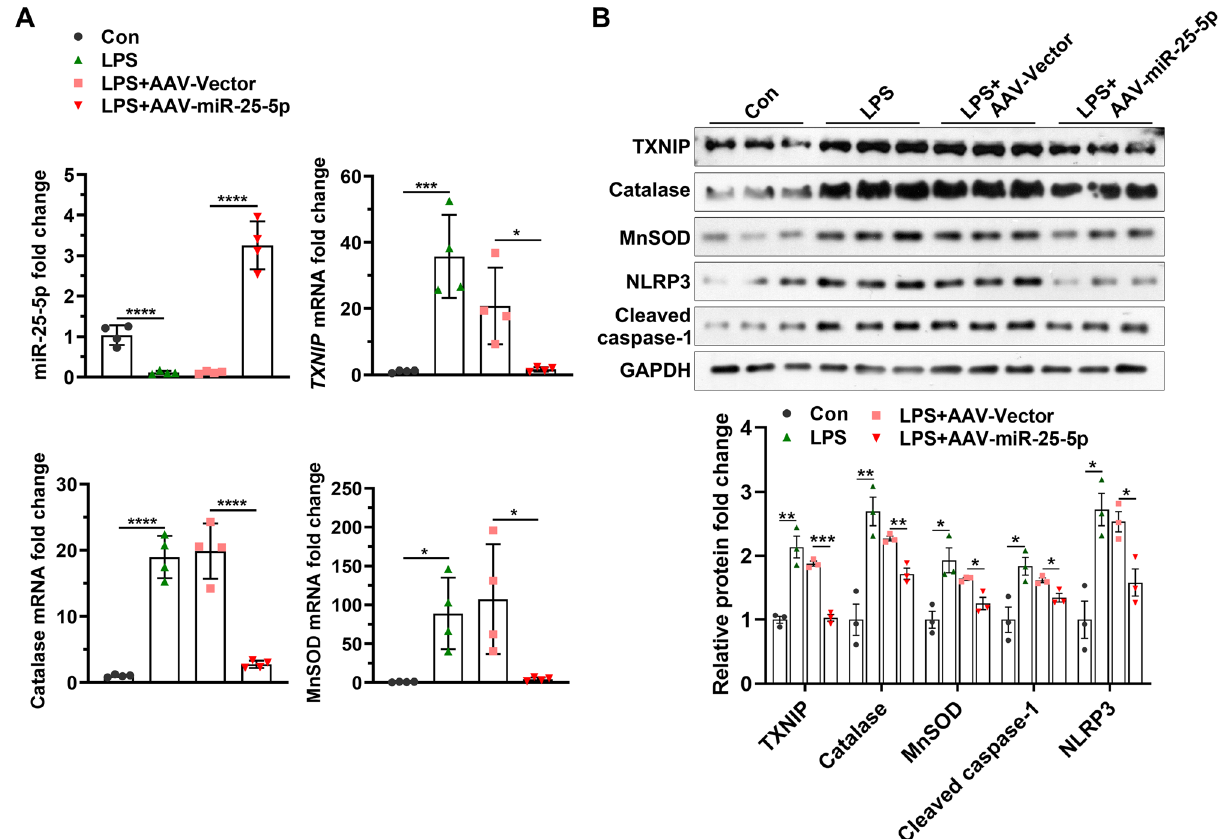
Figure 6. miR-25-5p negatively regulates signaling pathways in ROS response and apoptosis of the brain of septic rats. ( A ) Effects of AAV-miR-25-5p on miR-25-5p, TXNIP , catalase , and MnSOD mRNA fold changes ( A ), and TXINP, catalase, cleaved caspase-1, NLRP3, and MnSOD protein fold changes in the brain of septic rats ( B ). The relative expression levels of miRNA and mRNA were determined by qPCR and protein levels were determined by western blotting. The independent t -test was applied to the comparison between groups. Values are shown as the mean ± SD ( A , and B ). Con: negative control, LPS: lipopolysaccharide, AAV: adeno-associated virus. * P < 0.05. ** P < 0.01. *** P < 0.001. **** P <